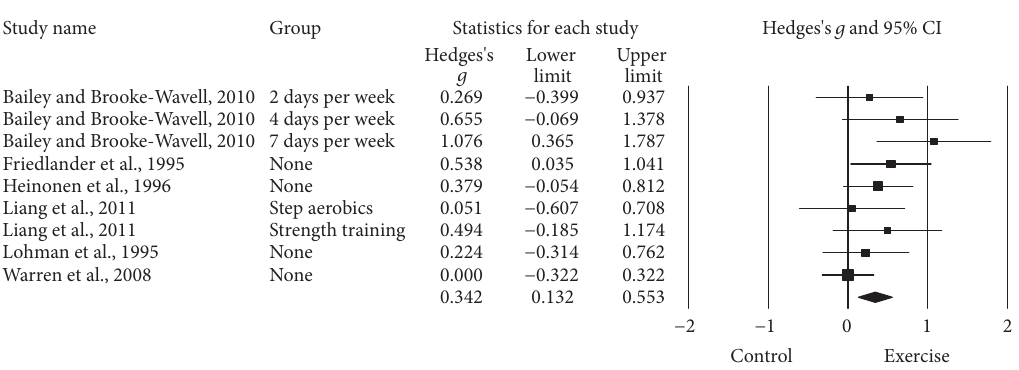
Exercise ) in FN BMD. e black squares con�dence ) while the le and right extremes of the 𝑔𝑔 % 𝑔𝑔